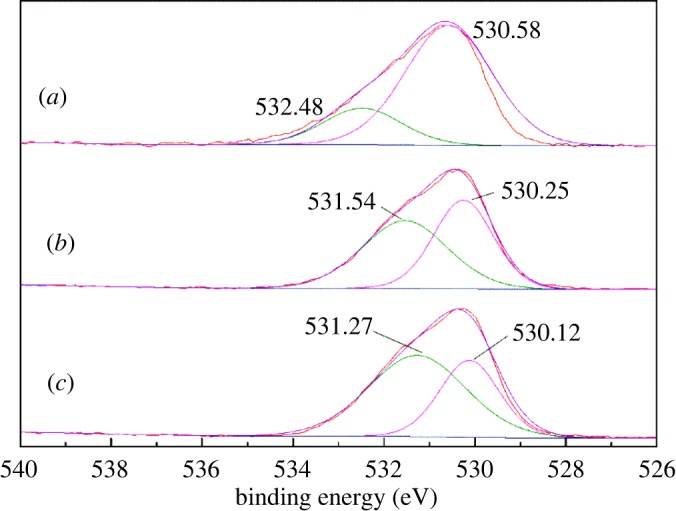
O1s XPS spectra of (a) cassiterite alone; (b) cassiterite in the presence of 20 mg l−1 Ca2+; (c) cassiterite in the presence of 45 mg l−1 OHA and 20 mg l−1 Ca2+.